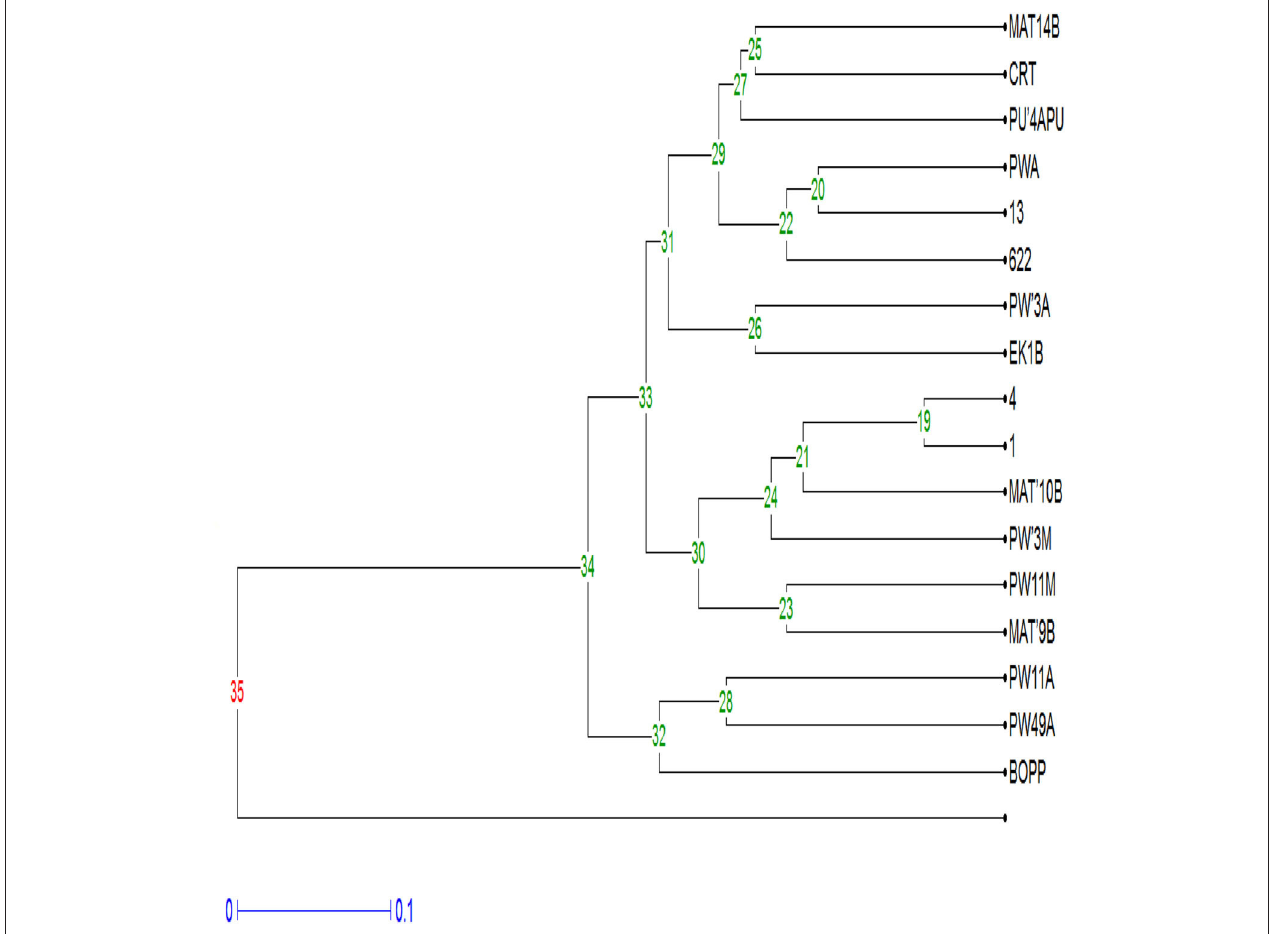
FIGURE 7 | Dendrogram of F. oxysporum f.sp. elaeidis strains amplified with ISSR molecular markers.